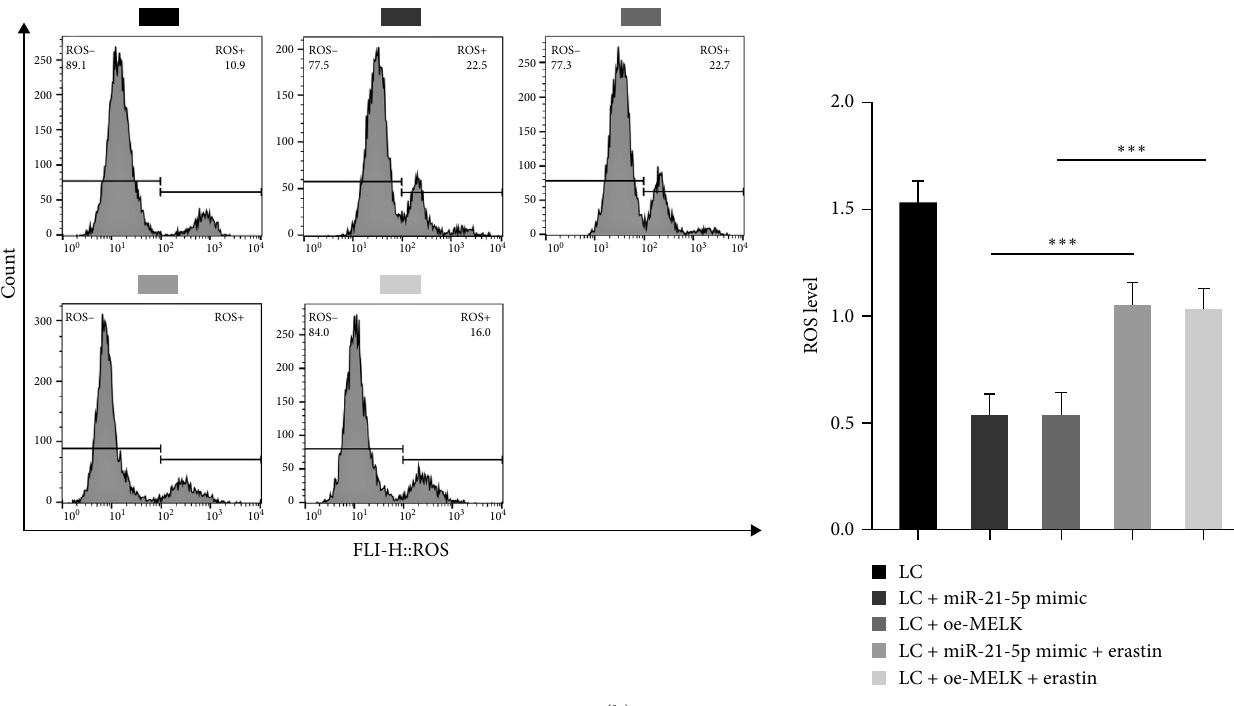
F IGURE 6: Animal experiments demonstrate that miR-21-5p inhibits ferroptosis in hepatocellular carcinoma cells by regulating the AKT/mTOR pathway through MELK: (a) tumor size in nude mice; (b) tumor growth curve; (c) tumor weight in nude mice; (d) staining of immunohistochemical Ki-67; (e) pathway-related proteins MELK, AKT, mTOR, p-AKT, p-mTOR, and ferroptosis-related proteins GPX4, HO-1, FTH1, and x CT were detected by Western blot. The levels of E-cadherin, vimentin, fi bronectin, and N-cadherin; (f) kit assay of the level of GSH; (g) kit assay of Fe 2+ content; (h) kit assay of ROS content, ∗ P < 0 : 05, ∗∗ P < 0 : 01, ∗∗∗ P < 0 :